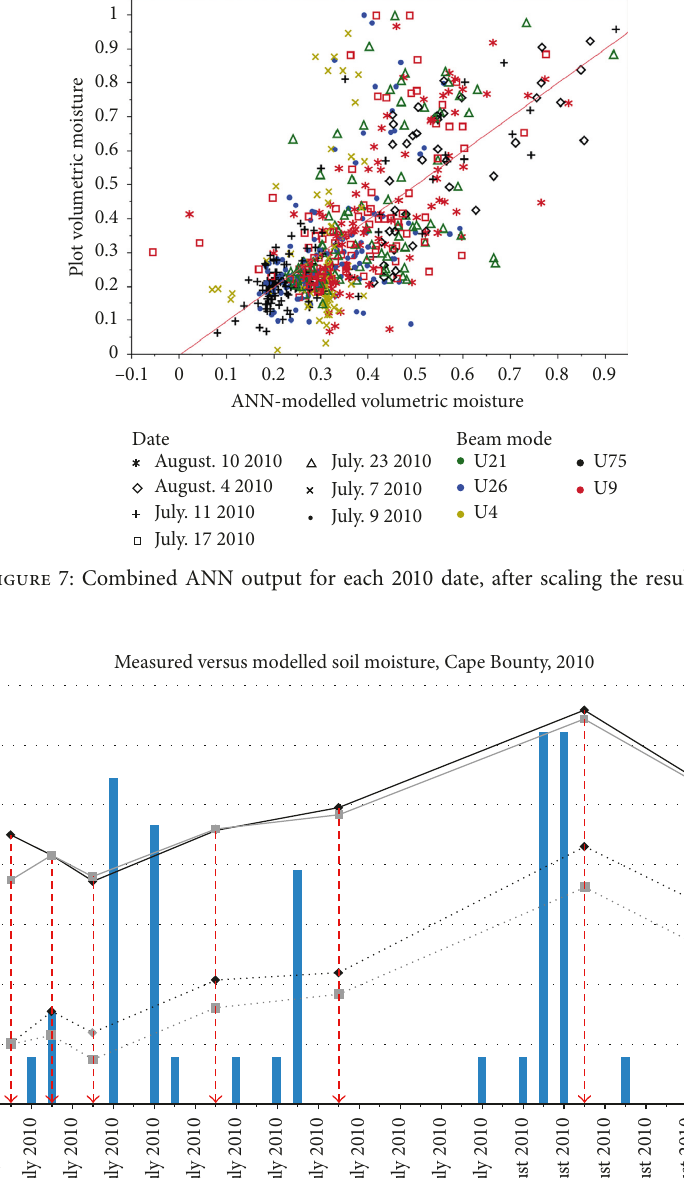
(Figure 7). The r 2 and RMSE values for the combined results are 0.46 and 0.155, respectively.